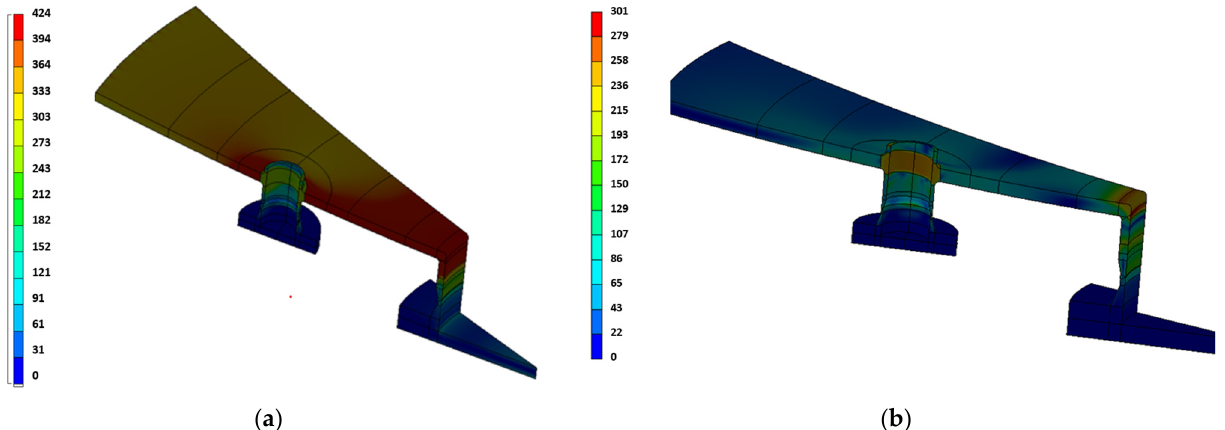
Figure 14. Contours of von Mises stresses within the lower manhole of the vessel for the time t = 9150 s, for which they reach the maximum value ( a ), for the time t = 83,910 s—corresponding to the condition of the unloaded tank (gravity only) residual stresses ( b ).